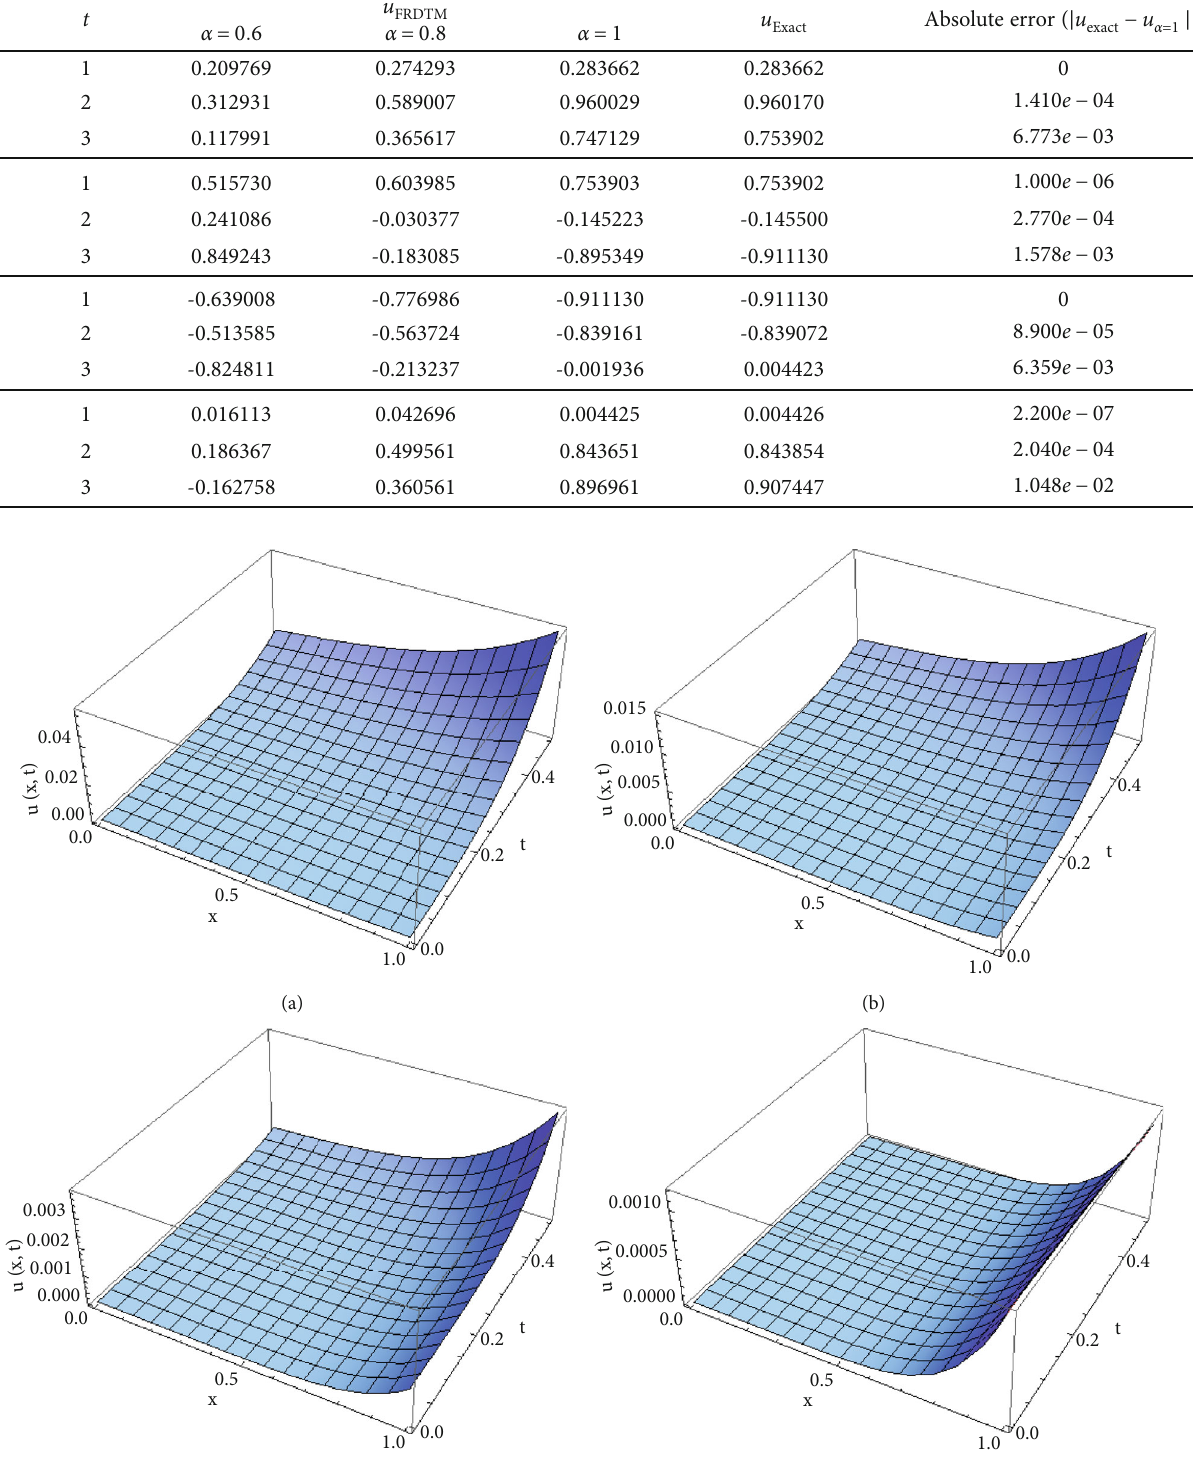
Table 1: Ninth-order approximate numerical solution by FRDTM of Eq. (21) at di ff erent values of α and comparison of absolute error at α = 1